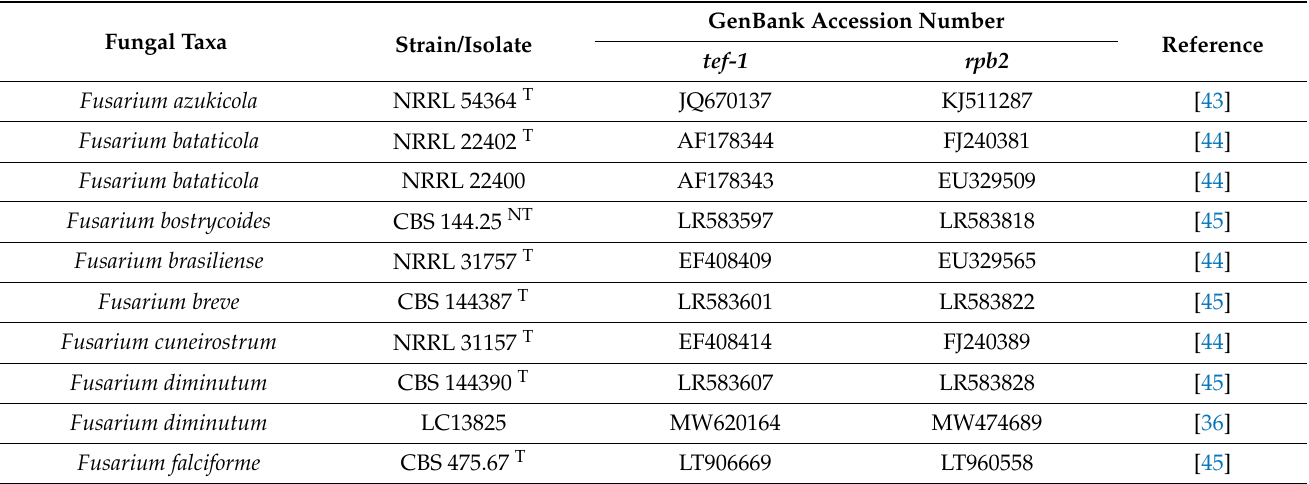
Table 2. Details of the Fusarium solani species complex sequences used in the molecular phylogenetic